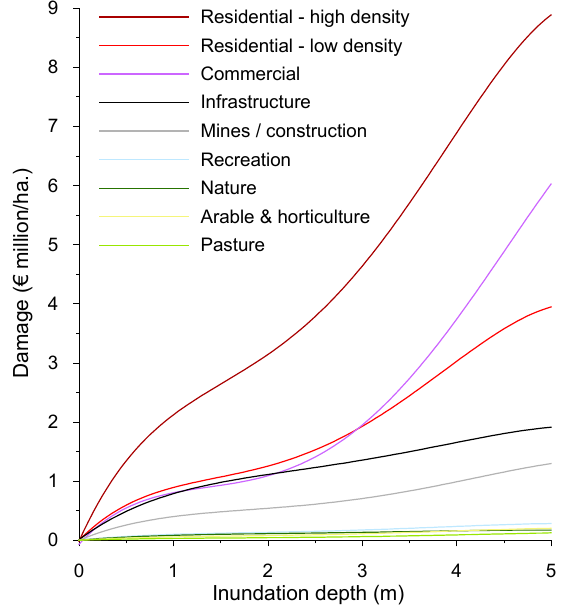
Fig. 3. Stage-damage functions used in the